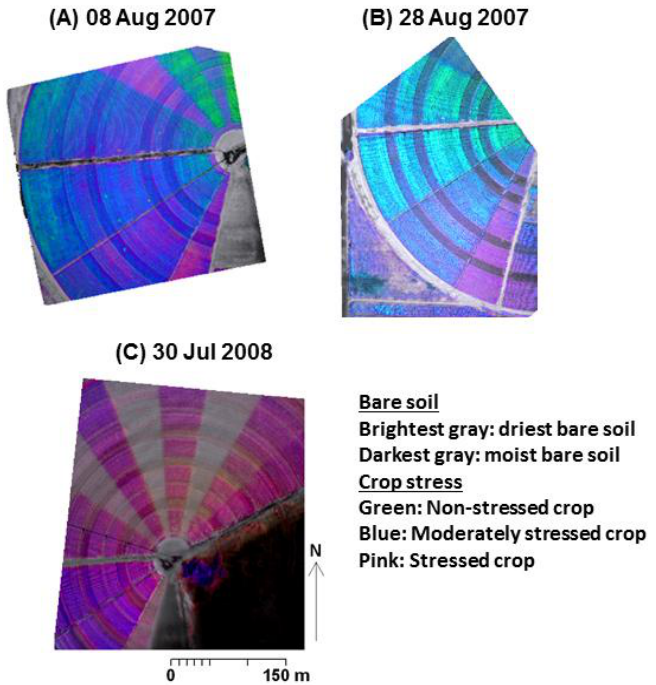
Figure 7. Color composites produced by hue, saturation and intensity (HIS) fusion of Ts-Ta (−30 °C to 30 °C), GC (0–100%) and SB (0–100%) for 2007 ( A , B ) and 2008 ( C